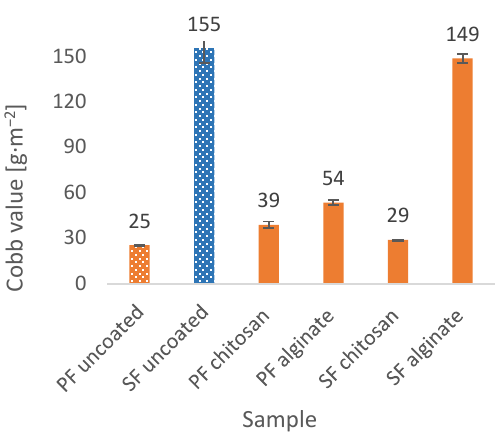
Figure 5. Cobb values for uncoated and coated samples measured for 60 s with deionized water ( n = 6).